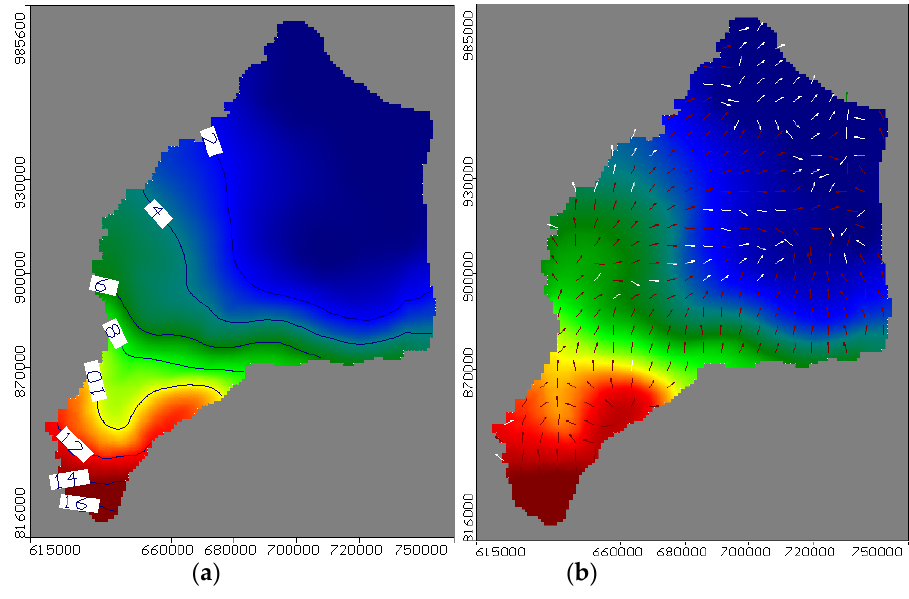
Figure 4. A real view of ( a ) groundwater levels and ( b ) flow pattern and velocity direction in the